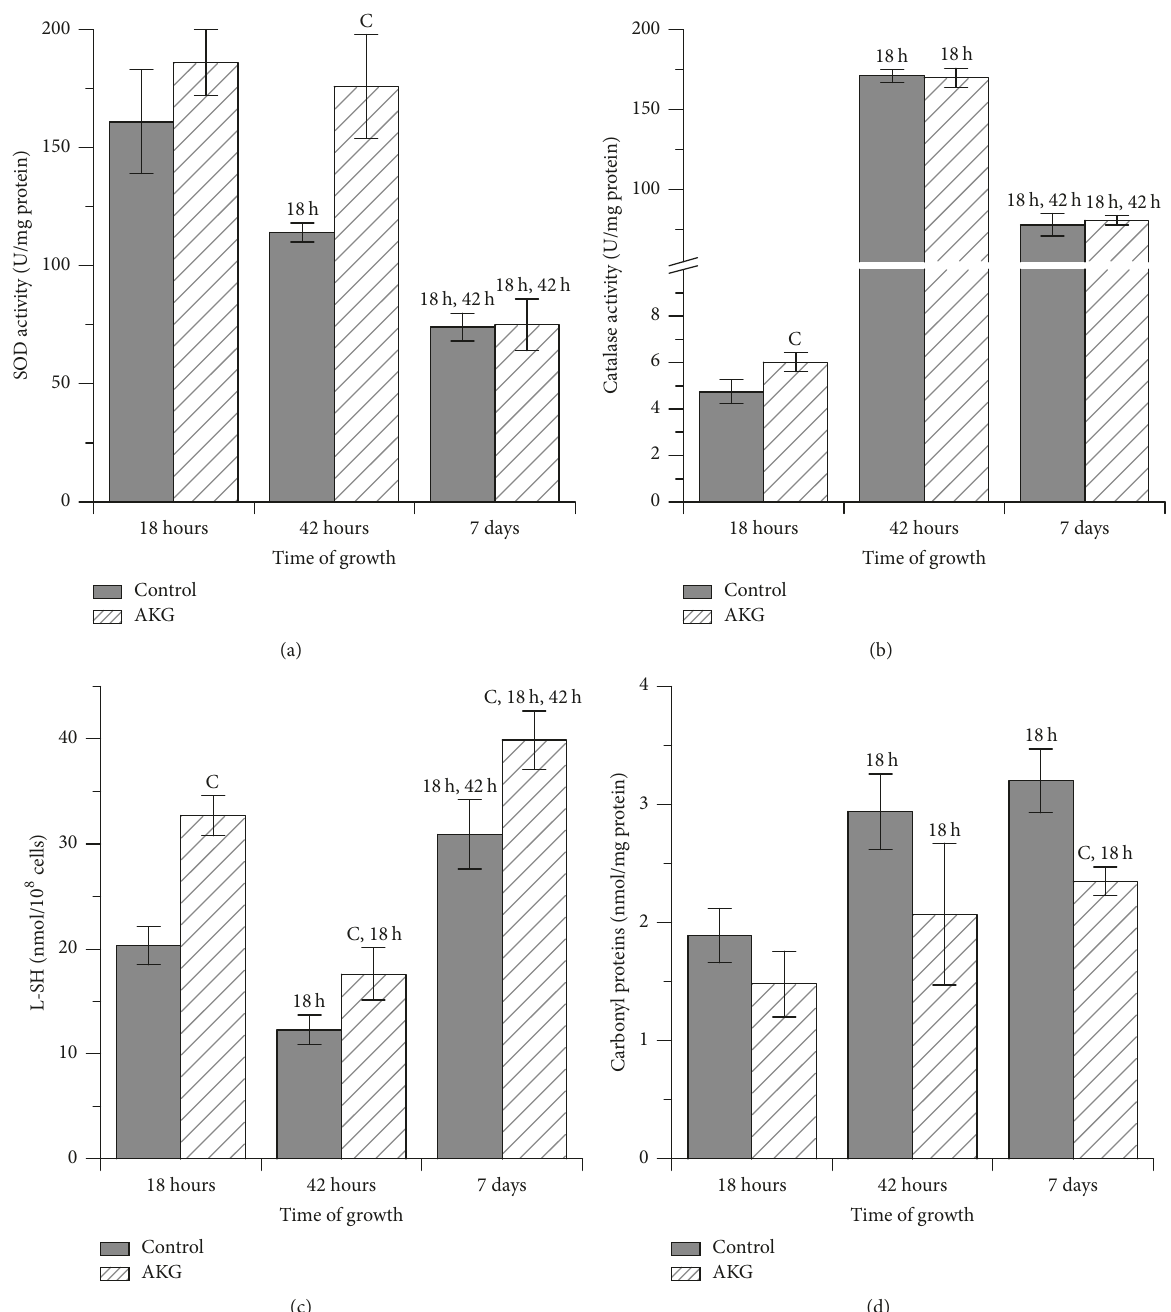
Figure 5: Activities of SOD (a) and catalase (b) and levels of low-molecular-mass thiols (c) and carbonyl proteins (d) in S. cerevisiae cells grown during 7 days in control medium or medium supplemented with 10 mM AKG. Results are shown as means ± SEM ( 𝑛 = 5 –7). Statistic as in Figure